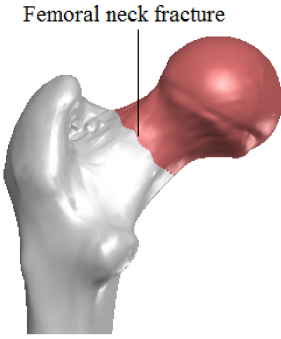
Figure 1. Femoral neck fracture.